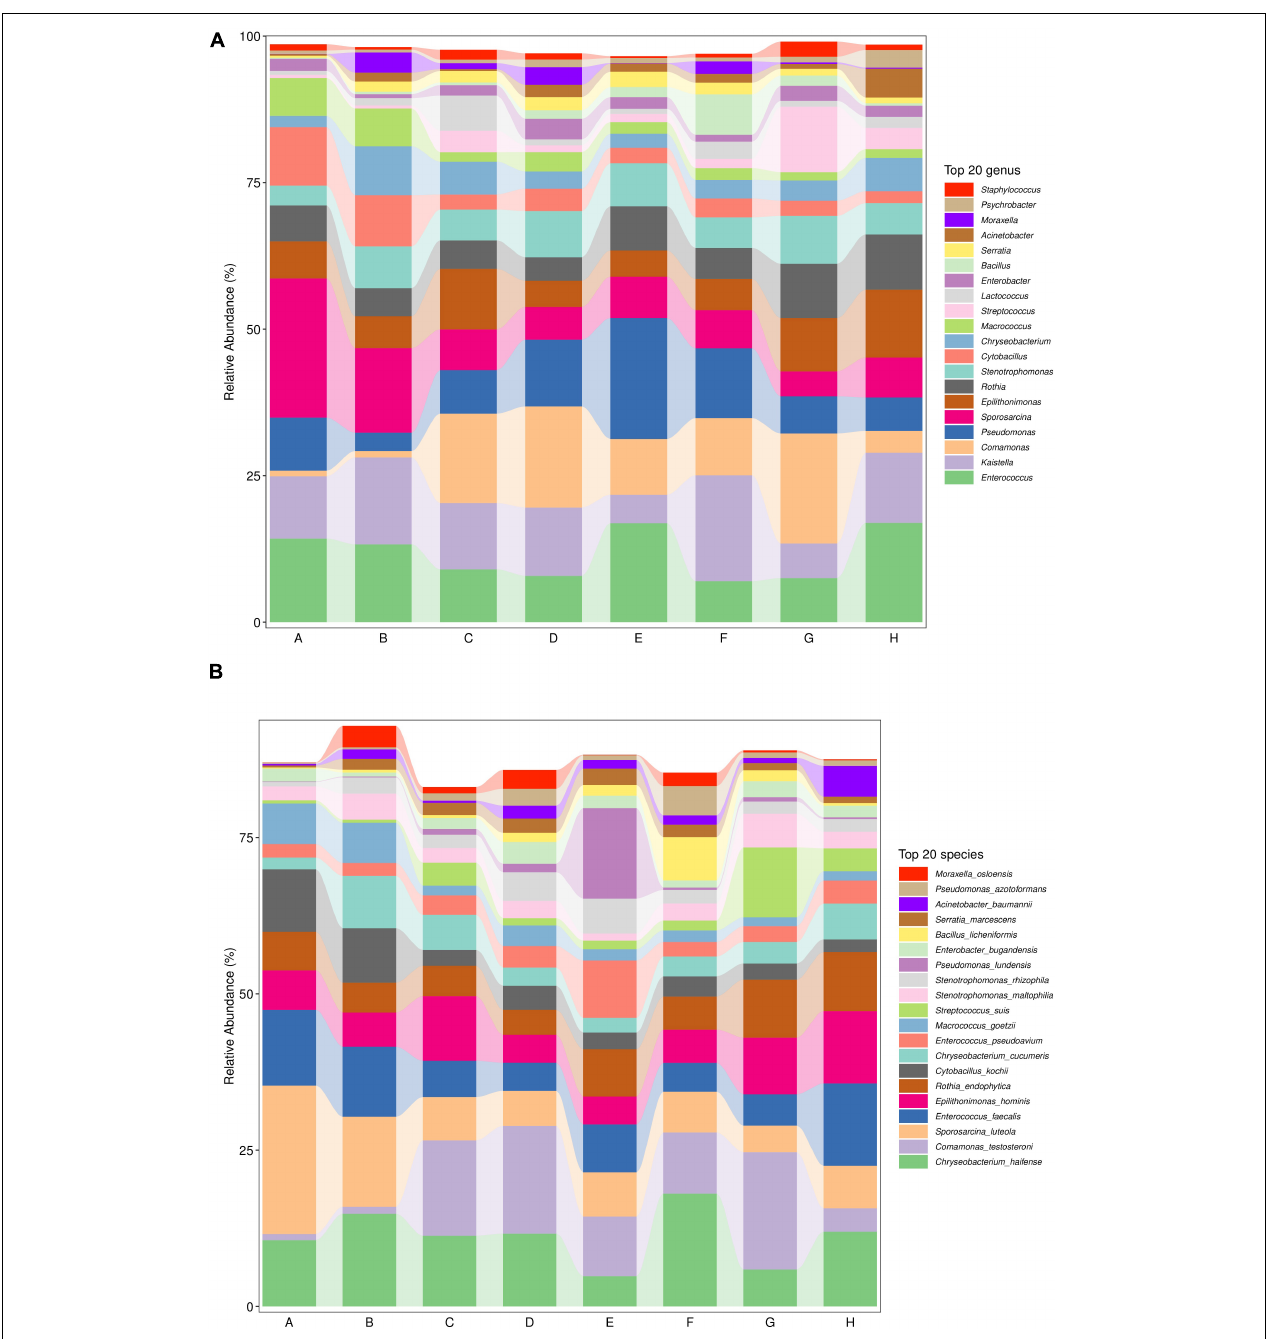
FIGURE 2 | Relative OTU abundance at the (A) genus and (B) species levels from raw milk samples used for this study. A. Heilongjiang, B. Inner Mongolia, C. Gansu, D. Henan, E. Anhui, F. Jiangsu, G. Chongqing, and H.